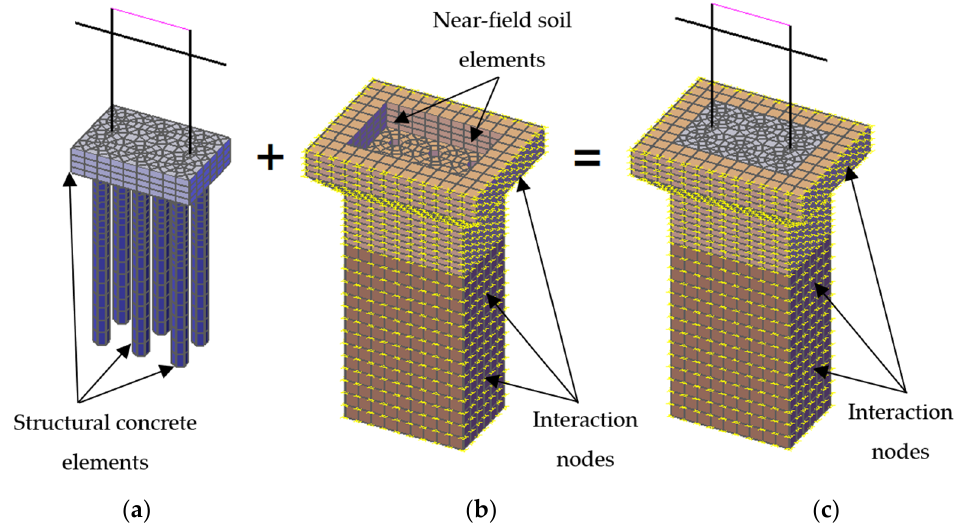
Figure 7. Finite element model in ACS SASSI: ( a ) structural model; ( b ) near-field soil volume; ( c ) complete model.